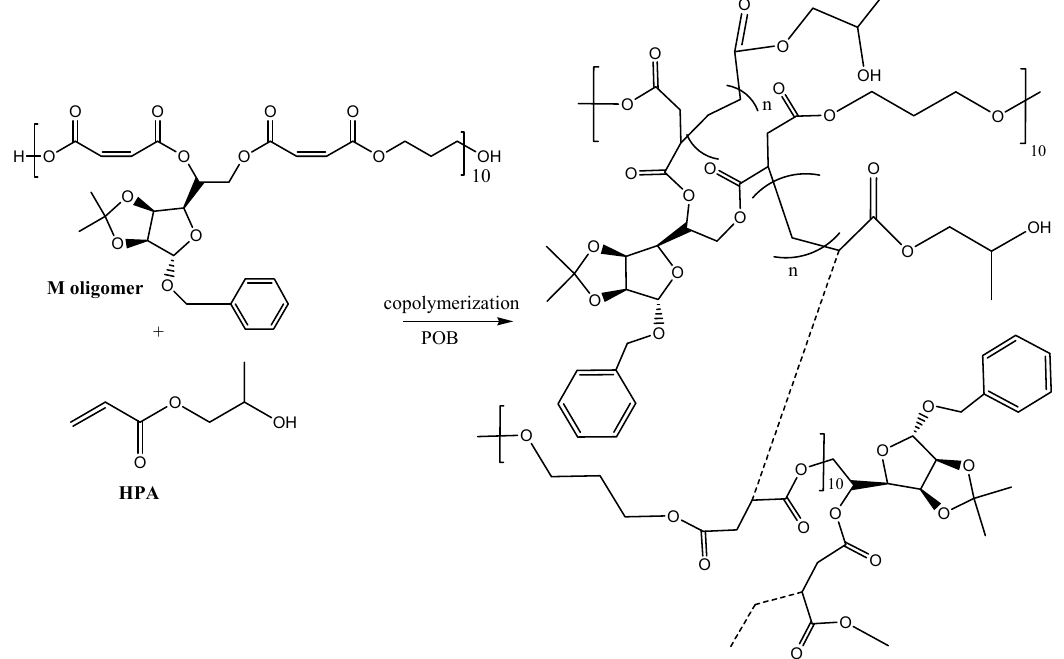
Scheme 1. The copolymerization reaction scheme between the D-mannose oligomer (M) and 2-hydroxypropyl acrylate hydroxypropyl acrylate (HPA).